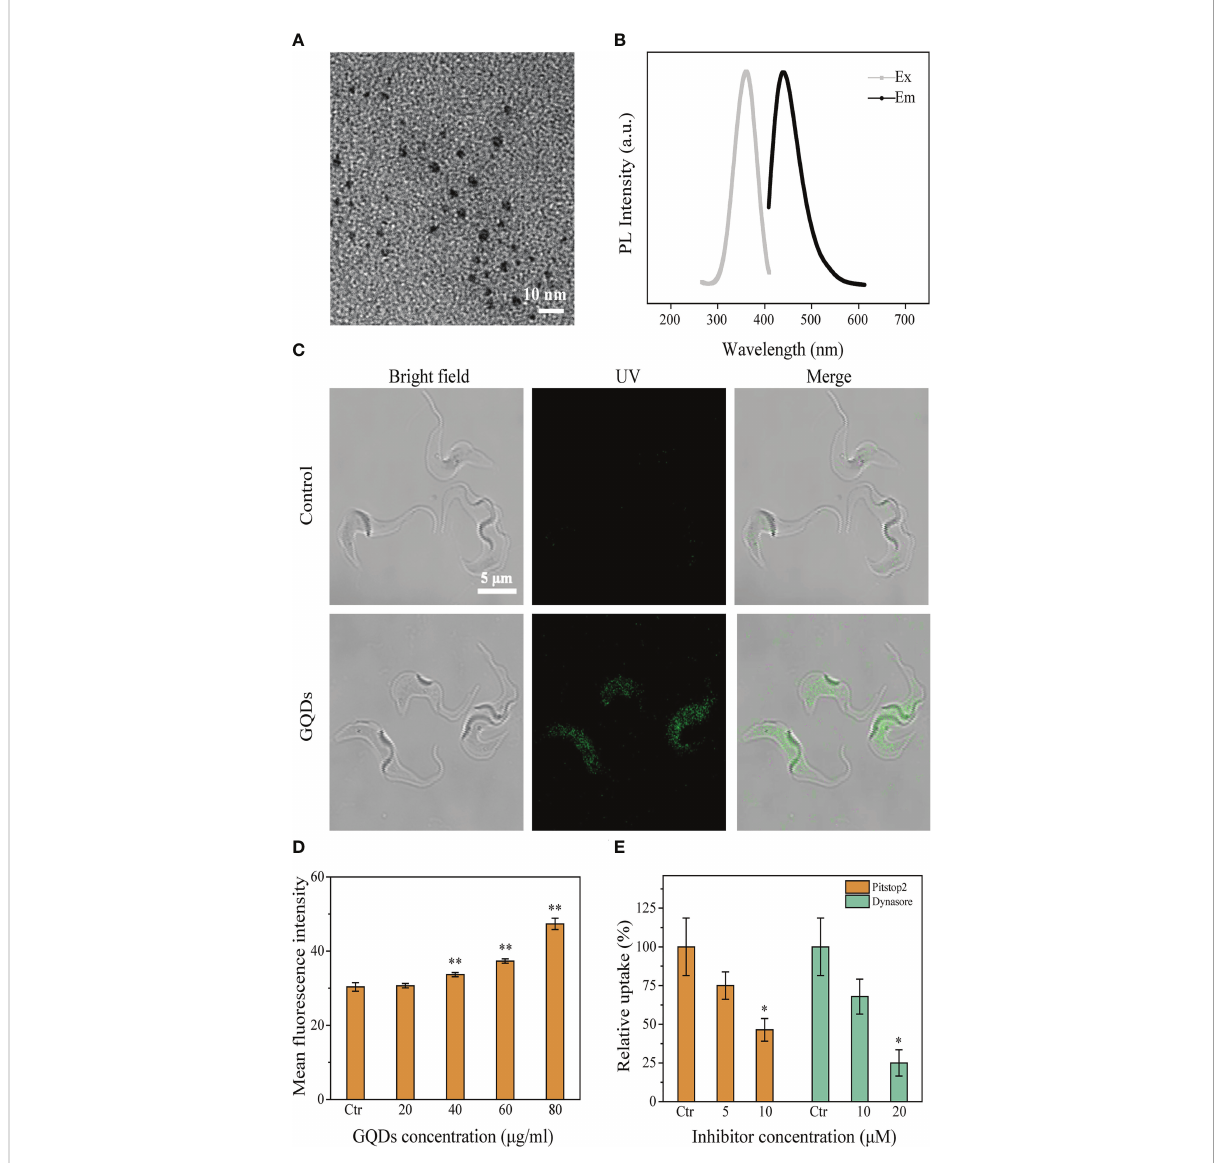
FIGURE 1 Characteristics of graphene quantum dots (GQDs) and their intracellular distribution in Trypanosoma brucei after co-incubation. (A) TEM images of GQDs (×80K). (B) Fluorescence spectra of GQDs. (C) Distribution of GQDs in T. brucei after incubation for 3 h. T. brucei with untreated parasites was taken as the control. GQDs were endocytosed and mainly distributed in the cytosol of the parasites. (D) Flow cytometry was used to measure the intracellular fl uorescence intensity after incubation for 3 h with a series of concentrations of GQDs. The fl uorescence intensi fi ed with the increase in the concentration of GQDs concentration. (E) Clathrin inhibitors (Pitstop2 ™ and Dynasore) impeded the endocytosis of GQDs by T. brucei. The inhibitory effect steadily increased with the increase in inhibitor concentration, measured by fl ow cytometry after 3 h of treatment. T. brucei parasites cultivated with GQDs without inhibitors were used as controls. All values are the mean ± SD of triplicates. * p < 0.05, ** p <